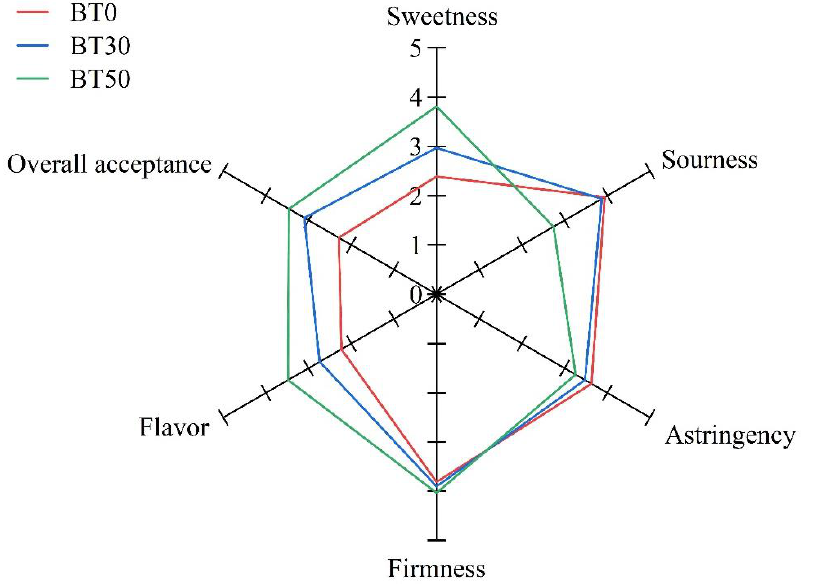
Figure 5. Effects of berry thinning on the sensory properties of Shine Muscat grapes: BT0, BT30, and BT50 indicate the level of berry thinning in terms of percentage.